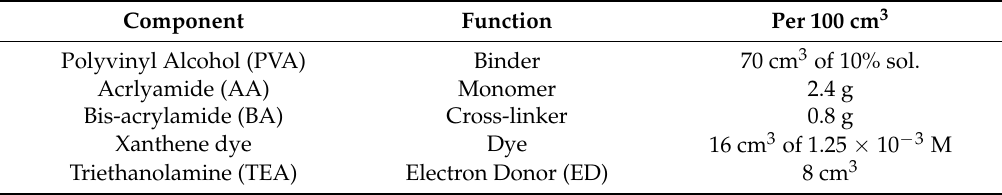
Table 1. Components of the photopolymer material used in this